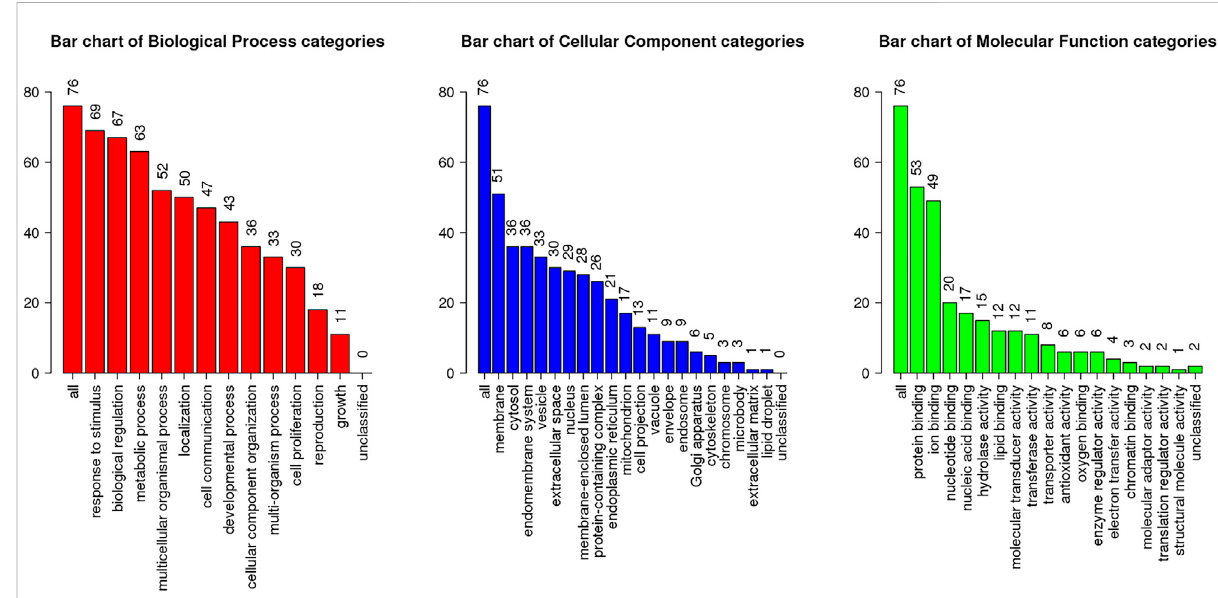
FIGURE 5 GO enrichment analysis of overlapping genes. The X-axis represents the GO enrichment entry, and the Y-axis represents the number of enriched genes in the GO enrichment terms, p <